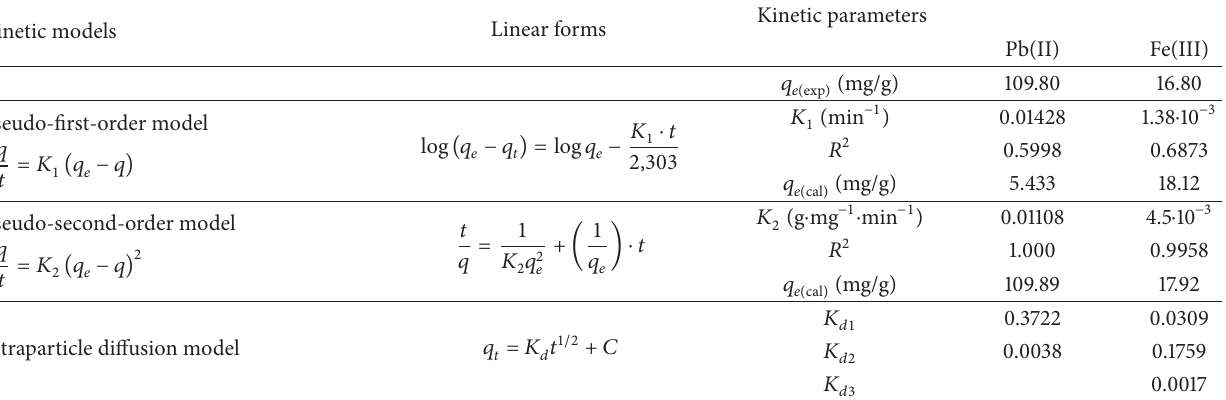
Table 3: Kinetic